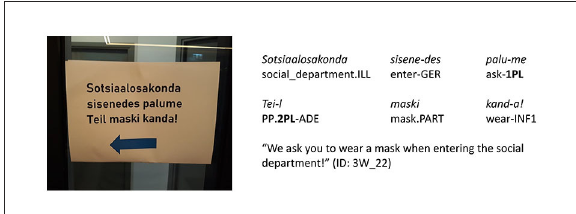
FIGURE1 Estonian COVID-19 door sign. Linguistic means represented on the sign: type of person usage “both 1st and 2nd person” (expressions_of_authority_NO + imperative_NO).